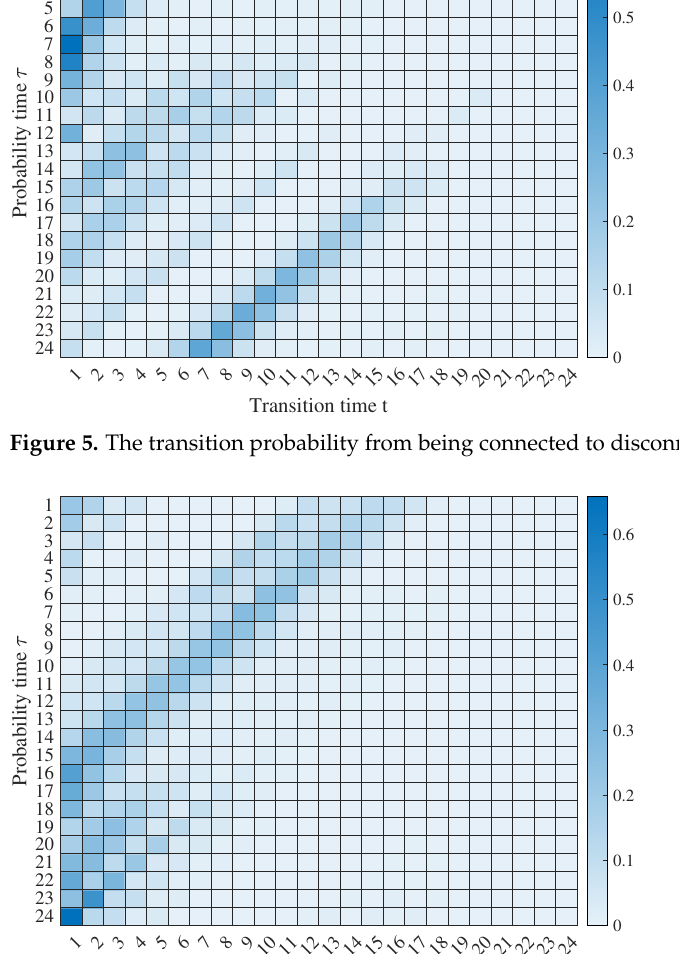
Figure 6. The transition probability from being disconnected to connected ( λ τ